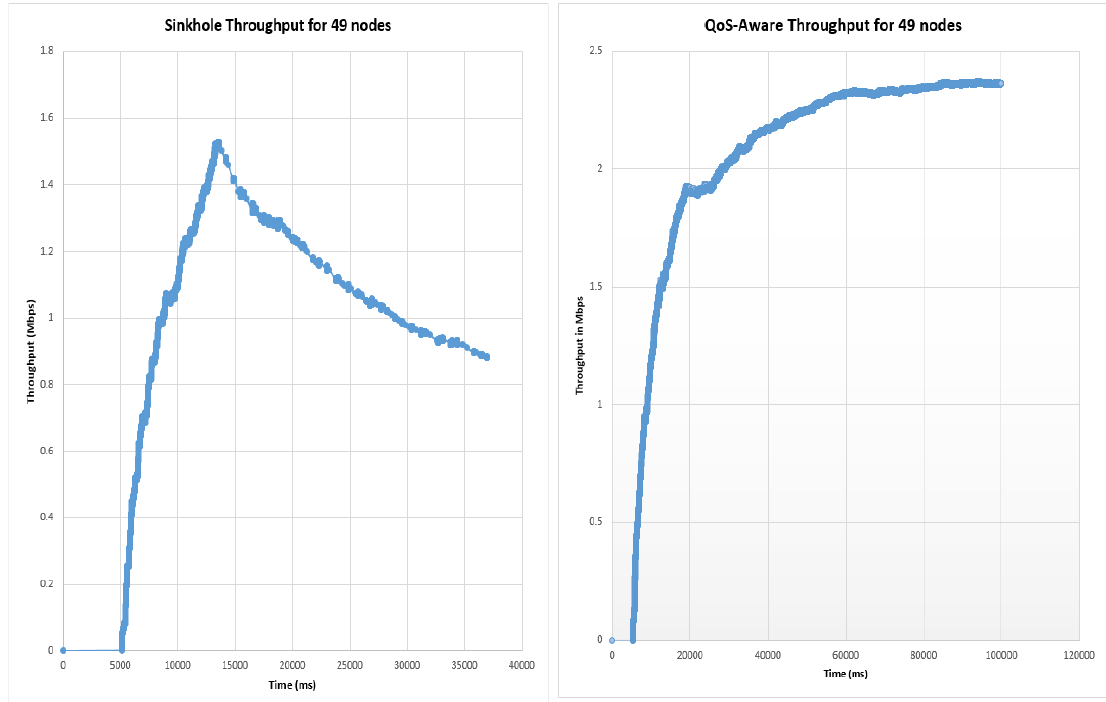
Figure 14. Throughput for sinkhole and framework scenarios.